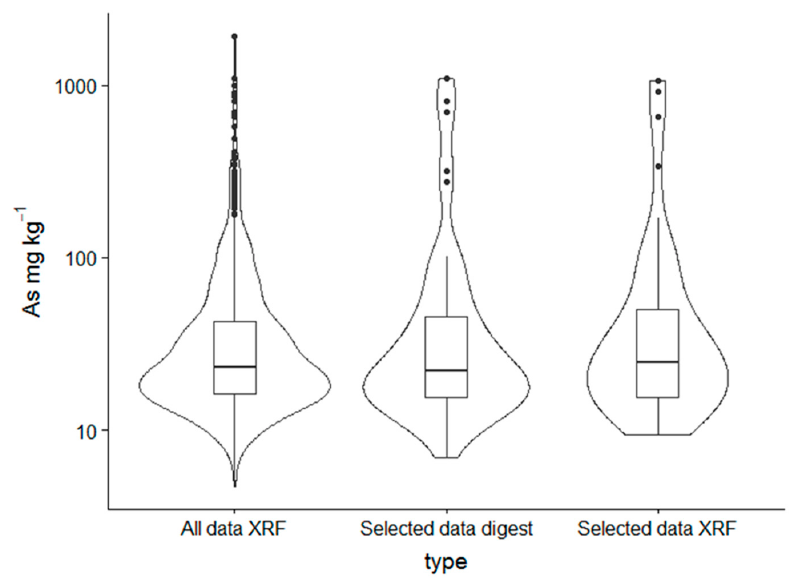
Figure 5. Combined box and whisker and violin plots of the total As data in the whole data set, the selected samples and the digest analysis of the <250 µm fraction of the selected soils.